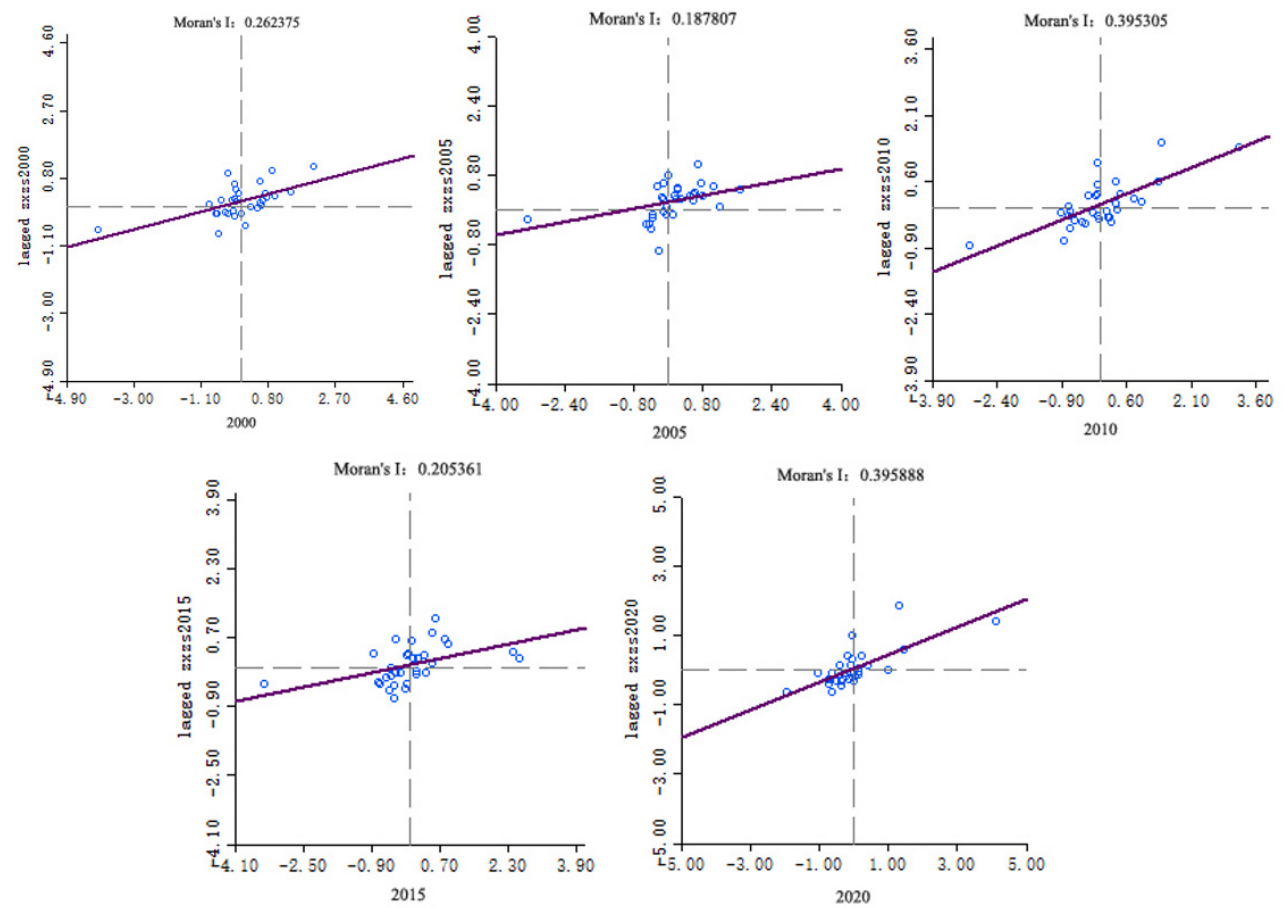
Figure 6. Moran’s I index value of GTCL.